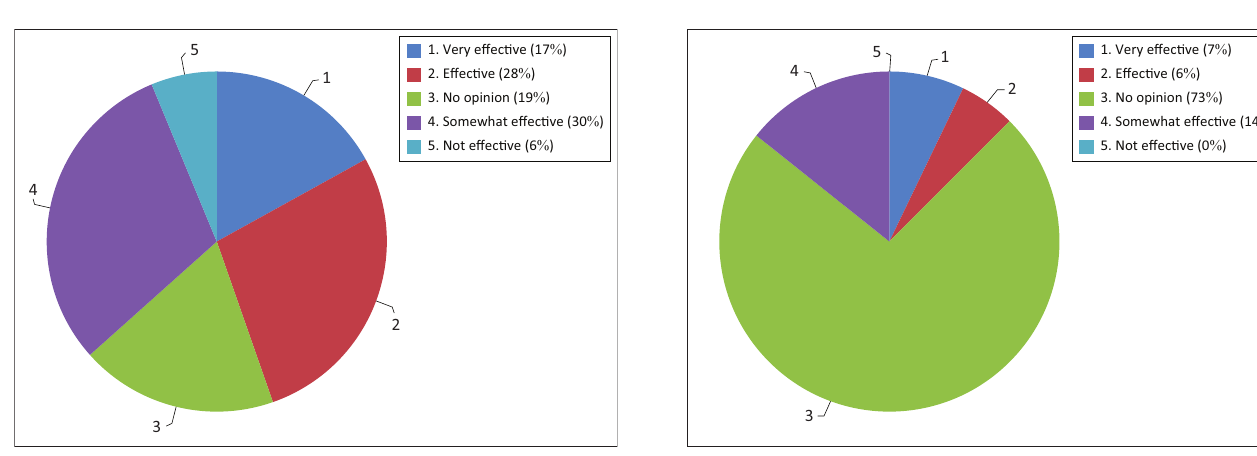
FIGURE 4: Participants’ opinions of storytelling as a knowledge transfer tool ( n = 112).